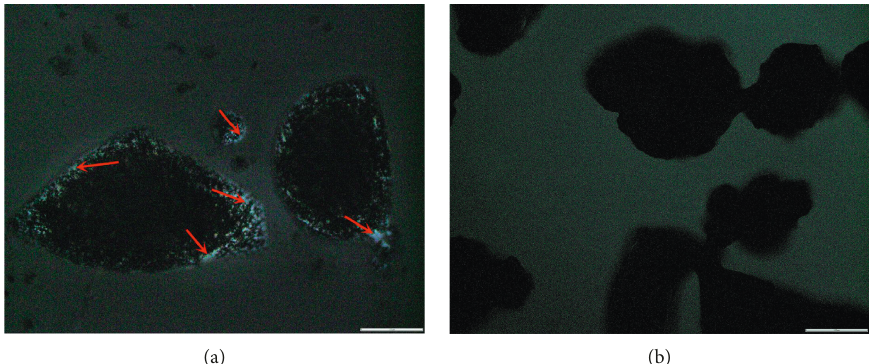
Figure 3: POM images taken below the crystallization temperature of PEG10000/9wt.%AB (a) and PEG10000/11.6wt.%AB (b) Scale bar: 100 μ m.